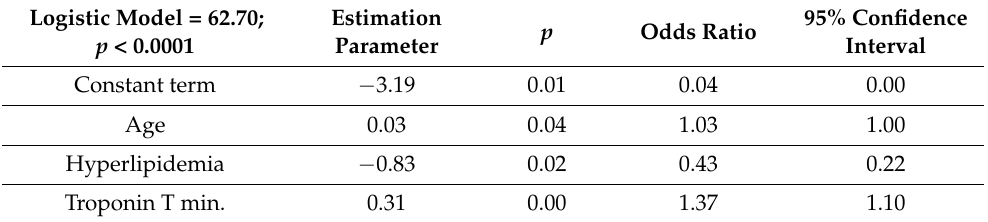
Table 4. Estimation results of the best logistic model for the probability of